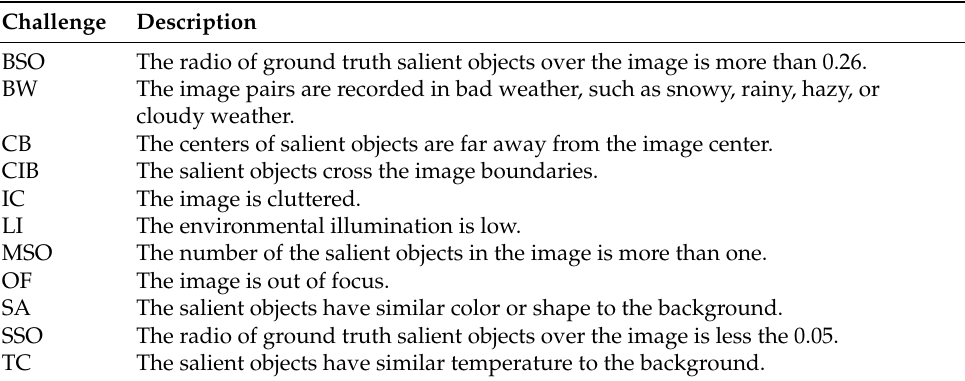
Table 1. List of the 11 challenging subsets of RGBT-Saliency-Dataset.